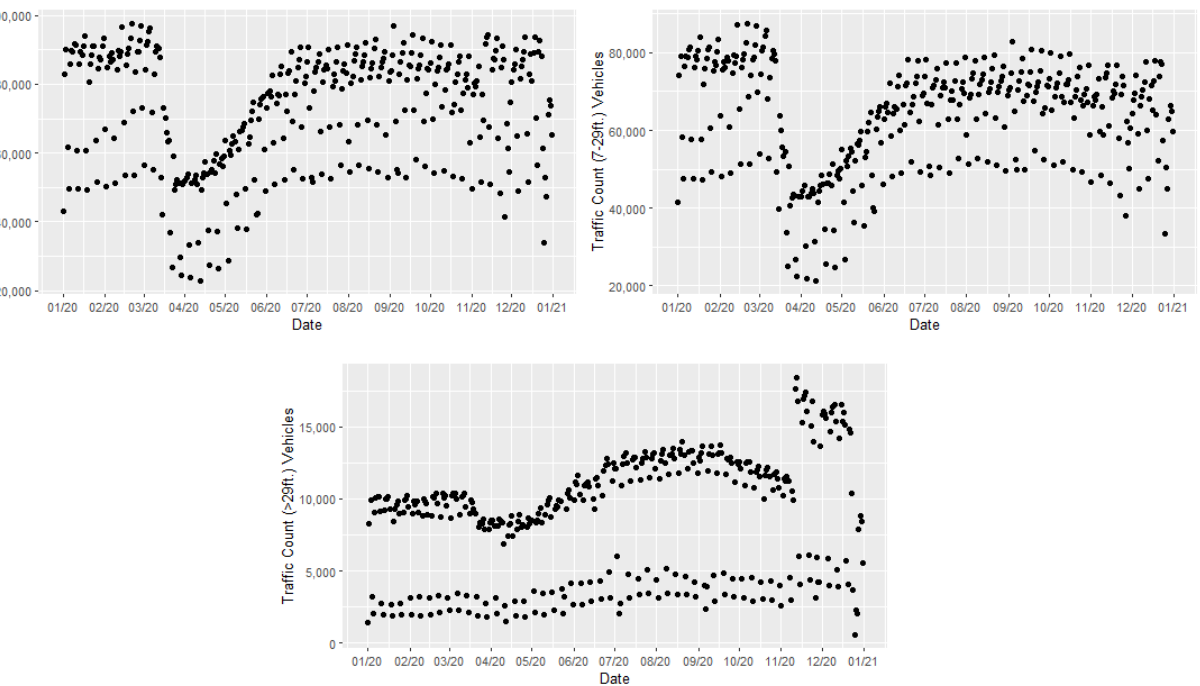
Figure 3. Reported daily average traffic counts at the Mt. Healthy site during 2020 for total traffic ( top left ), 7–29 ft ( top right ), and >29 ft ( bottom center ).